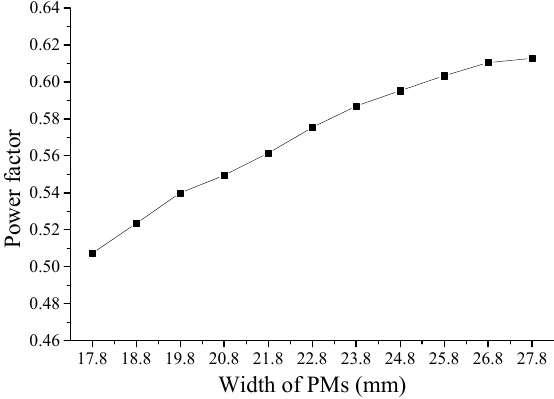
Figure 22. Variation of power factor versus width of PMs.